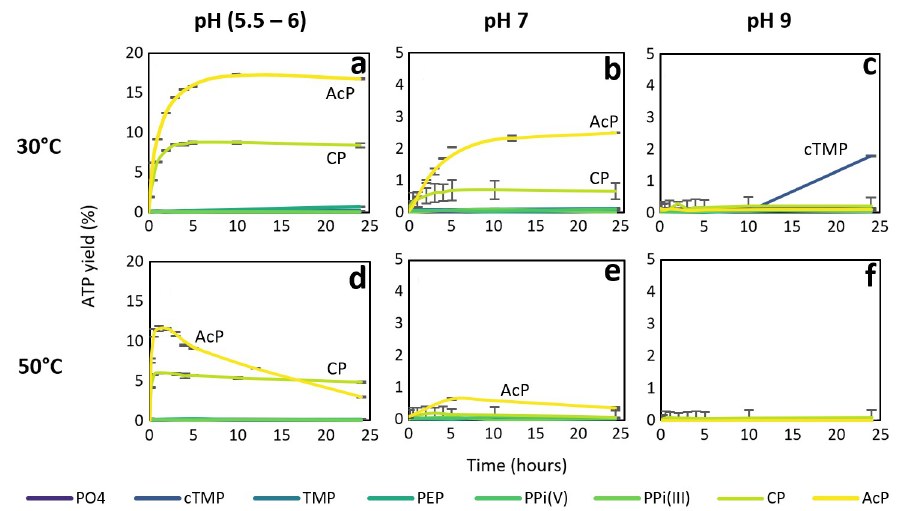
Fig 3. ATP synthesis with different phosphorylating agents. 1 mM:4 mM ADP:phosphorylating agent reaction catalysed by Fe 3+ with various phosphorylating agents at different pH and temperature. AcP, acetyl phosphate; CP, carbamoyl phosphate; cTMP, trimetaphosphate; PEP, phosphoenolpyruvate; PO 4 : potassium phosphate; PPi(III), pyrophosphite; PPi(V), pyrophosphate; TMP, trimethyl phosphate. N = 3 ± SD. ( a ) ATP yield (%) over 24 h at pH approximately 5.5–6 and 30˚C; ( b ) ATP yield (%) over 24 h at pH 7 and 30˚C; ( c ) ATP yield (%) over 24 h at pH 9 and 30˚C; ( d ) ATP yield (%) over 24 h at pH approximately 5.5–6 and 50˚C; ( e ) ATP yield (%) over 24 h at pH 7 and 50˚C; ( f ) ATP yield (%) over 24 h at pH 9 and 50˚C. The data underlying this figure can be found in Table H–M in S1 Data (sheet 3).